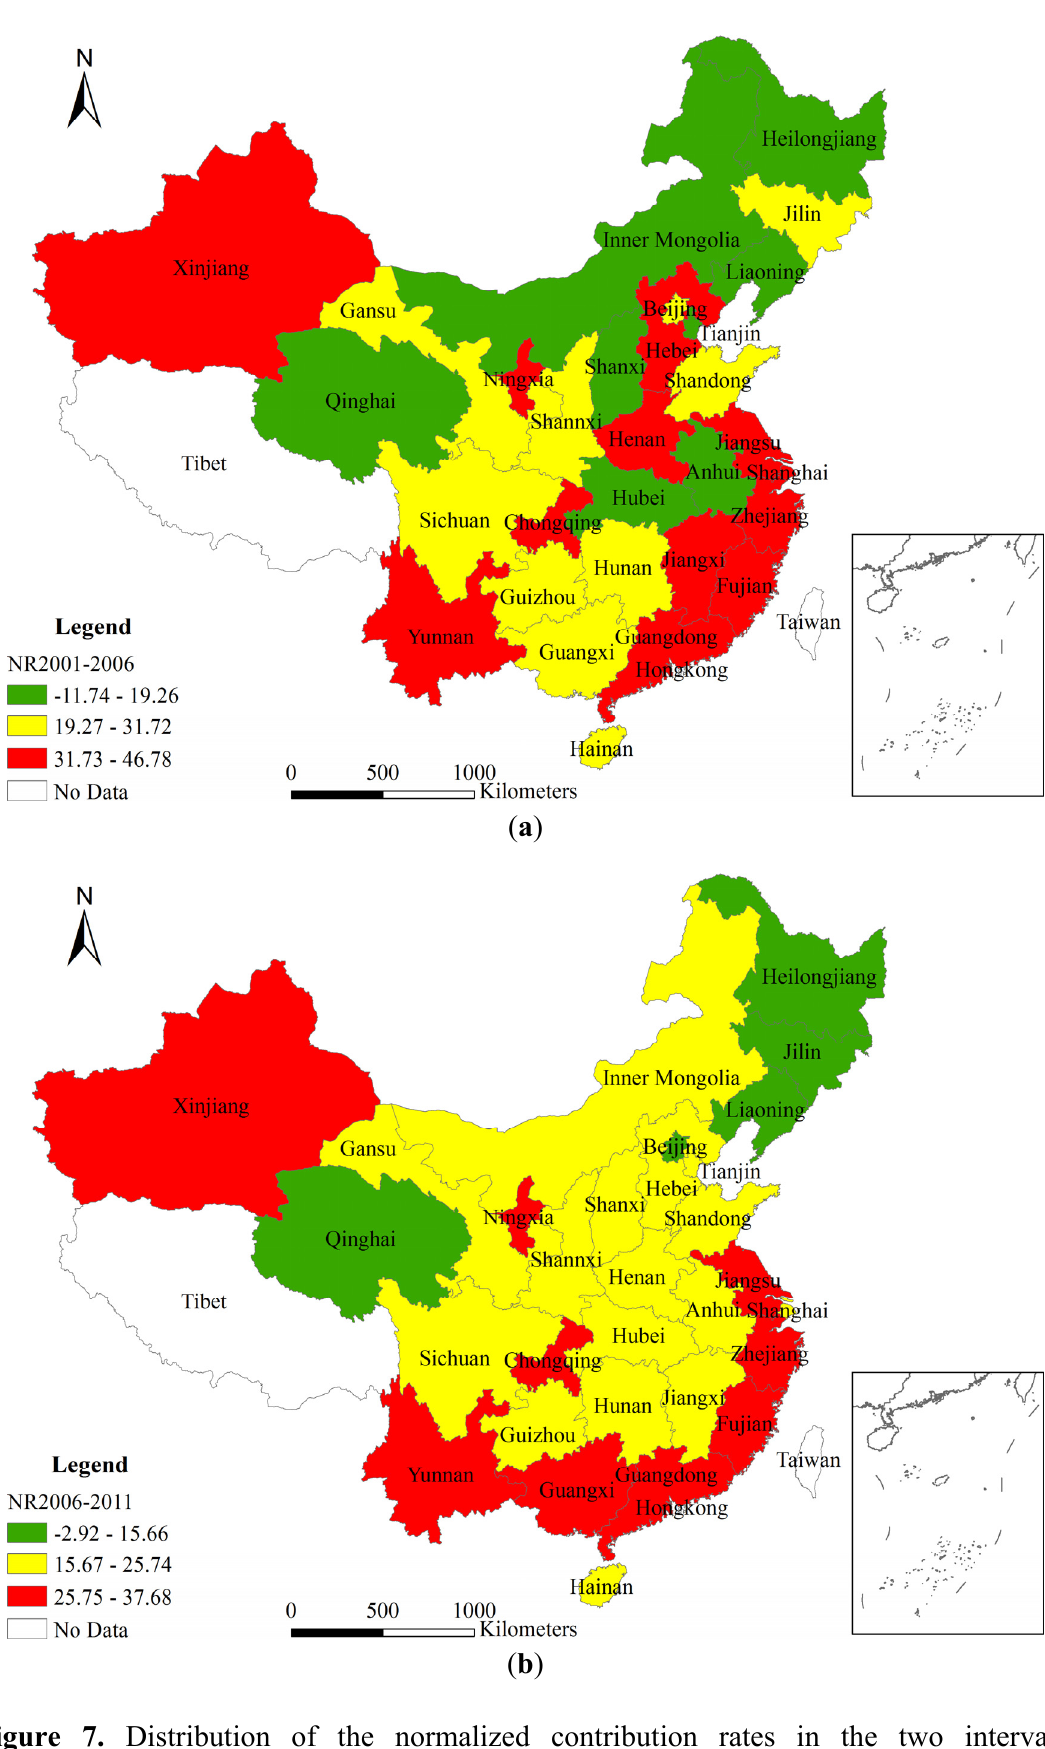
Figure 7. Distribution of the normalized contribution rates in the two intervals. ( a ) 2001–2006; ( b )